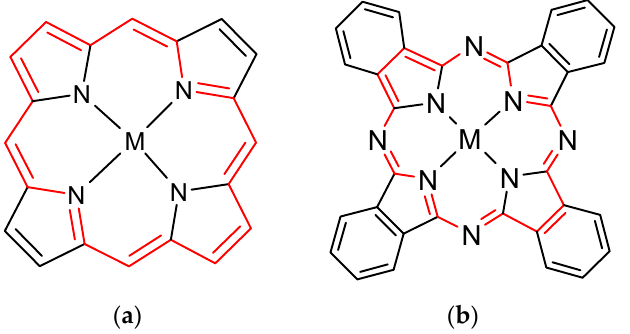
NN NN Scheme 1. Metalloporphyrins ( a ) and metallophthalocyanines ( b ) showing the 18 π -electron tetrapyrrole macrocycle (in red). For metal-free porphyrin or metal-free phthalocyanine, M is two hydrogens. For antimony(III)–phthalocyanine derivatives (Scheme 2) in ethanol solution, the molar extinction coefficient is 1.059 × 10 5 and 1.717 × 10 5 dm 3 · mol − 1 · cm − 1 at ~730 nm for unsubstituted Sb(III) phthalocyanine and 1.06 × 10 5 dm 3 · mol − 1 · cm − 1 at ~740 nm for octa-substituted Sb(III) phthalocyanine, whereas for Sb(V) phthalocyanine, the molar extinction coefficient is 1.908 × 10 5 dm 3 · mol − 1 · cm − 1 at 699 nm [15,16].